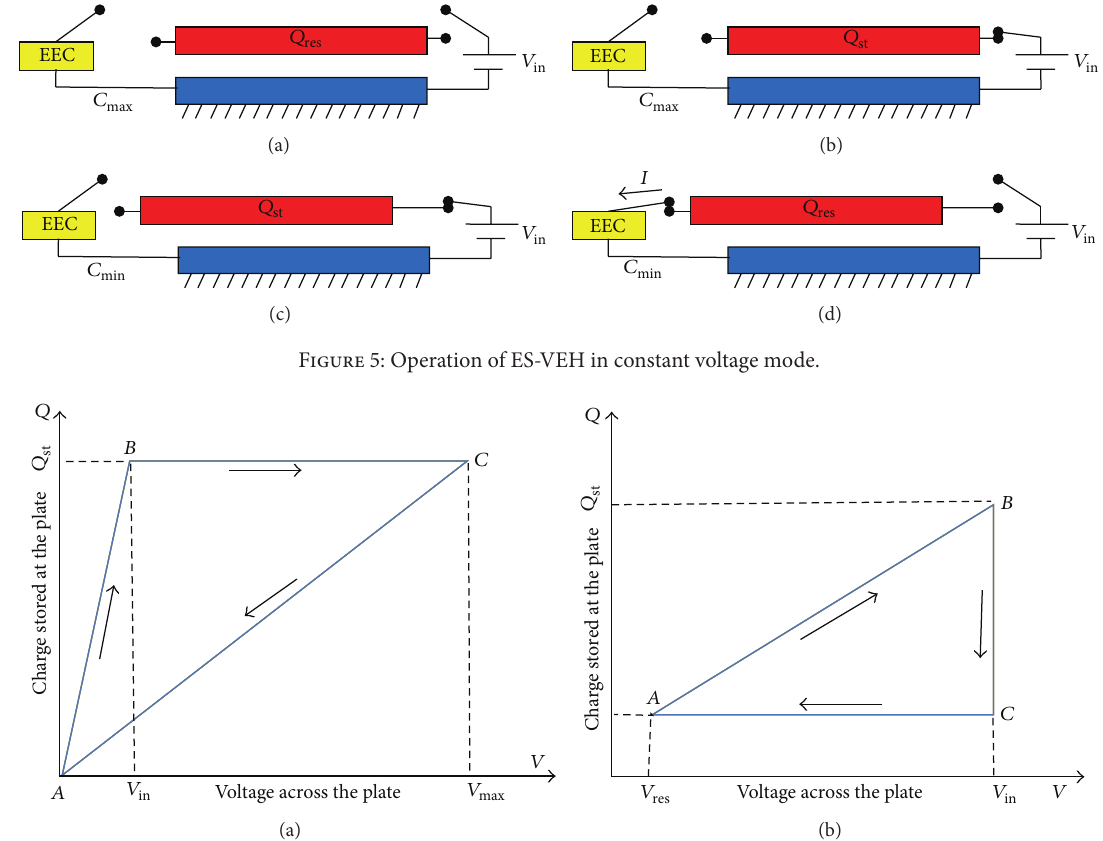
Figure 6: (a) Charge versus voltage at constant charge mode. (b) Charge versus voltage at constant voltage